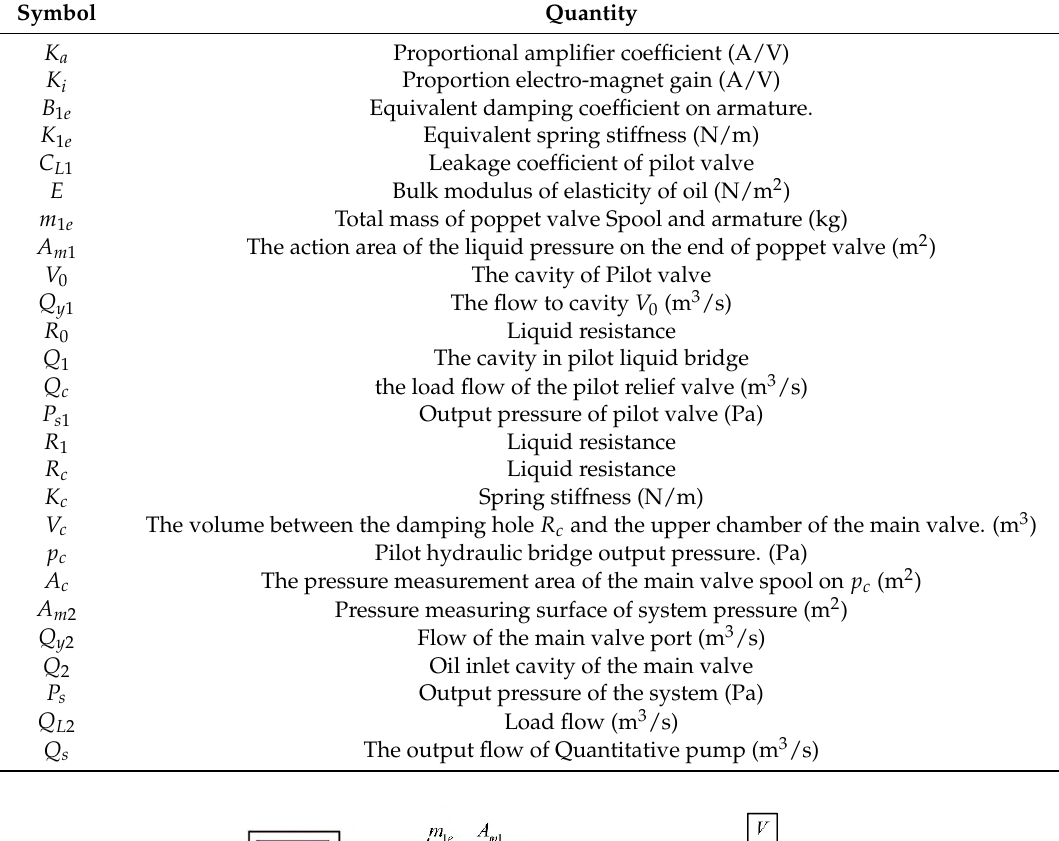
Table 1. Parameters value of transfer function.